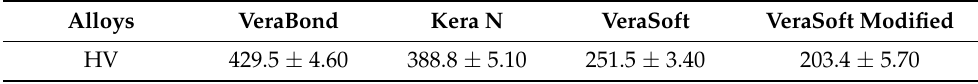
Table 2. The hardness values for alloys studied.